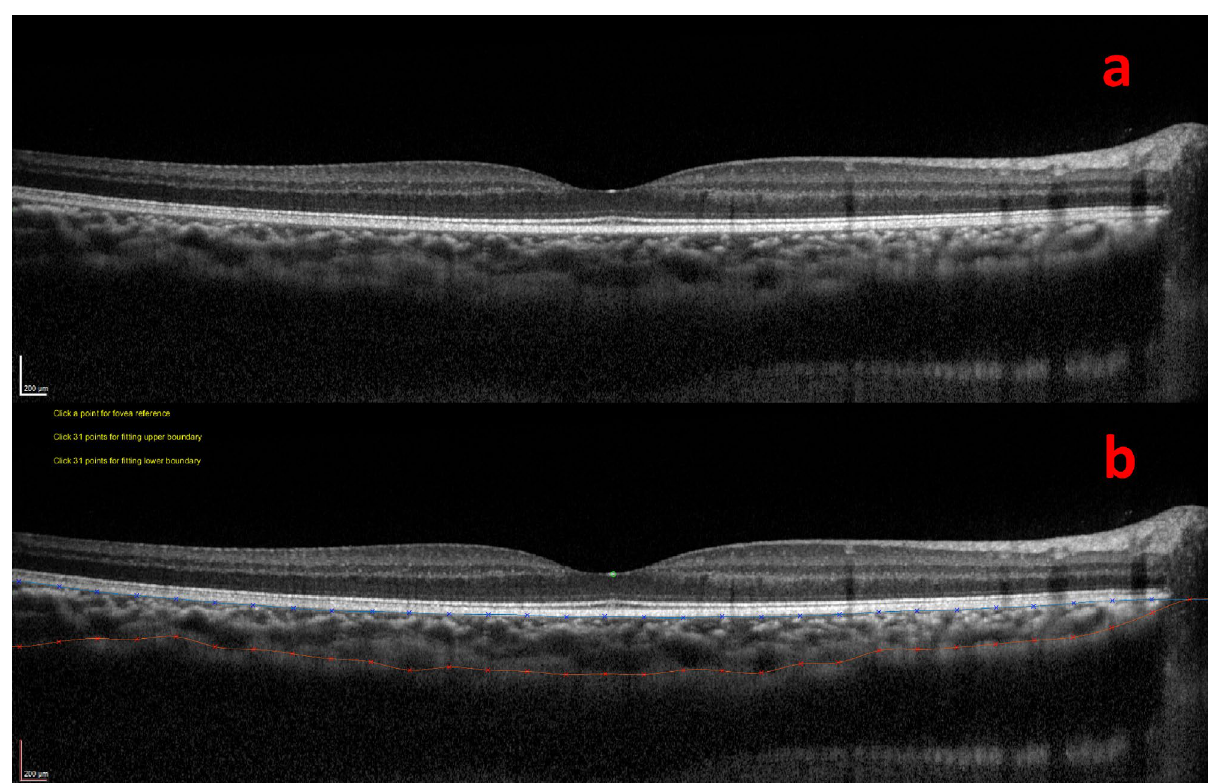
Figure 1. Measurement of choroidal thickness using the MATLAB software in spectral-domain optical coherence tomography (SD-OCT). ( a ) Presentation of the choroidal thickness before segmentation. ( b ) Manual segmentation of choroid by MATLAB